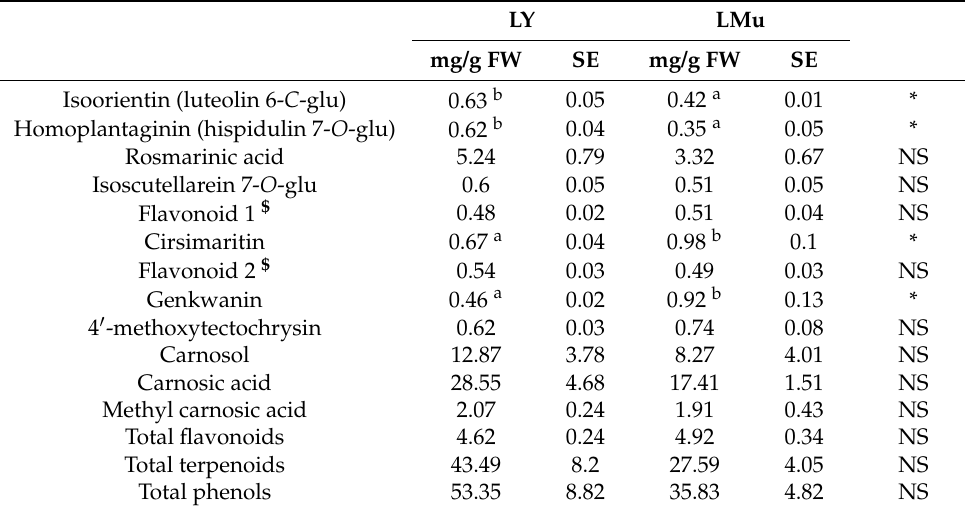
Table 1. Average amounts (mg/g FW) of phenolic compounds in young leaves (LY) and mature foliar tissue samples collected from the upper part of the branch (LMu). FW, fresh weight; SE, standard